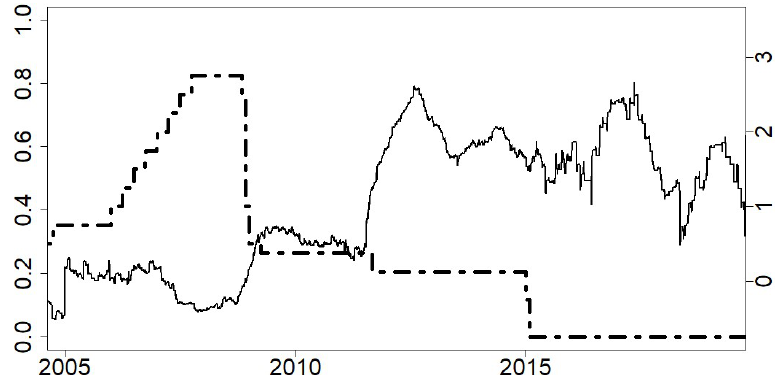
Figure 2. Left axis: Proportion of partially protected products among all capital protected products and interest rate levels from 2004 to 2019. Right axis: Swiss policy interest rate (dash-dot).